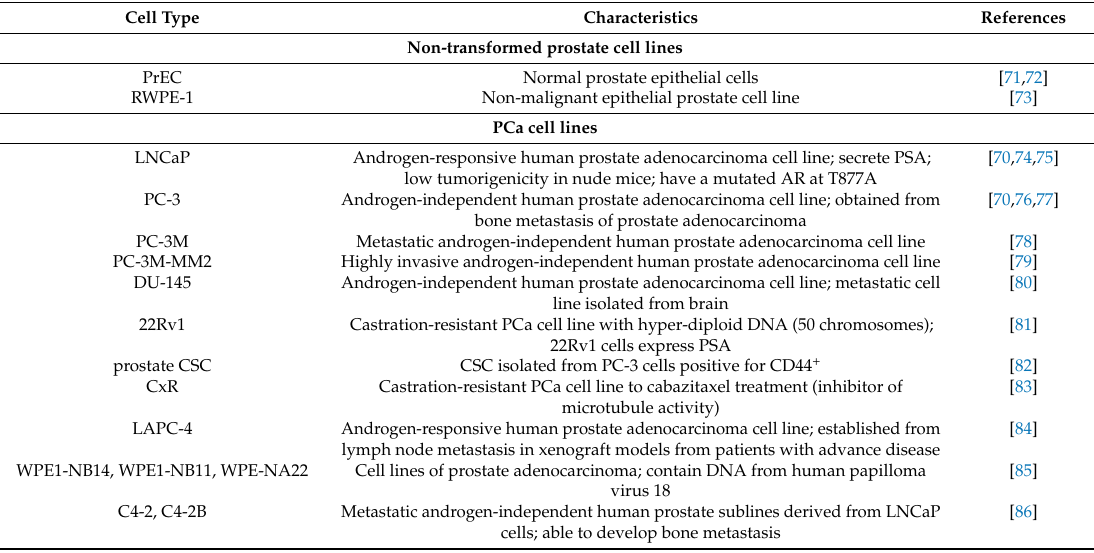
Table 2. Main characteristics of cell lines used to study prostate cancer.